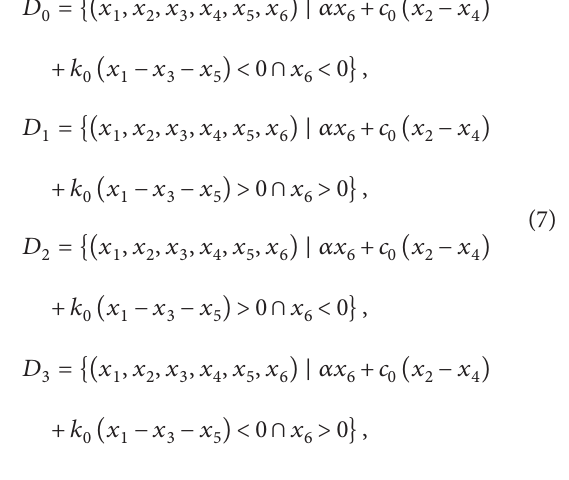
𝑘 = 1 528.1, 𝑘 1 2 0373.7, 𝛽 = 2 33849.1, 𝛾 = 8 816.9, 𝑐 𝑛 = 2 , 𝐴 = 2 0.6, and 𝑥